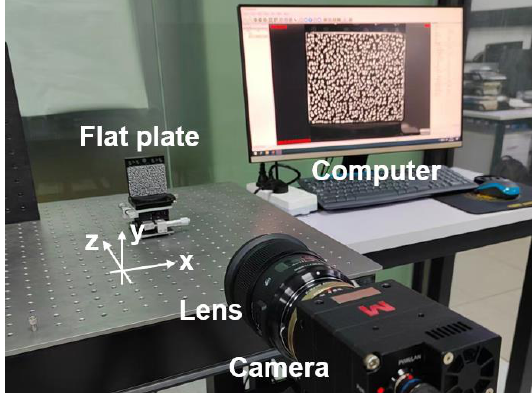
Figure 3. Experimental arrangement of in-plane and out-of-plane translation tests.